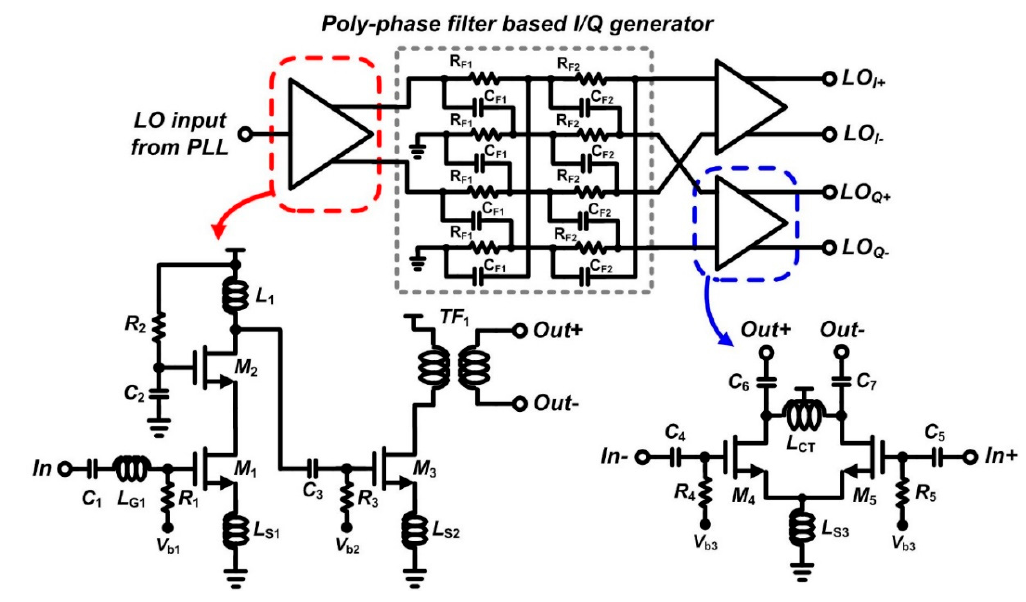
Figure 5. Simplified schematic of the proposed poly-phase filter-based I / Q LO generation circuits.